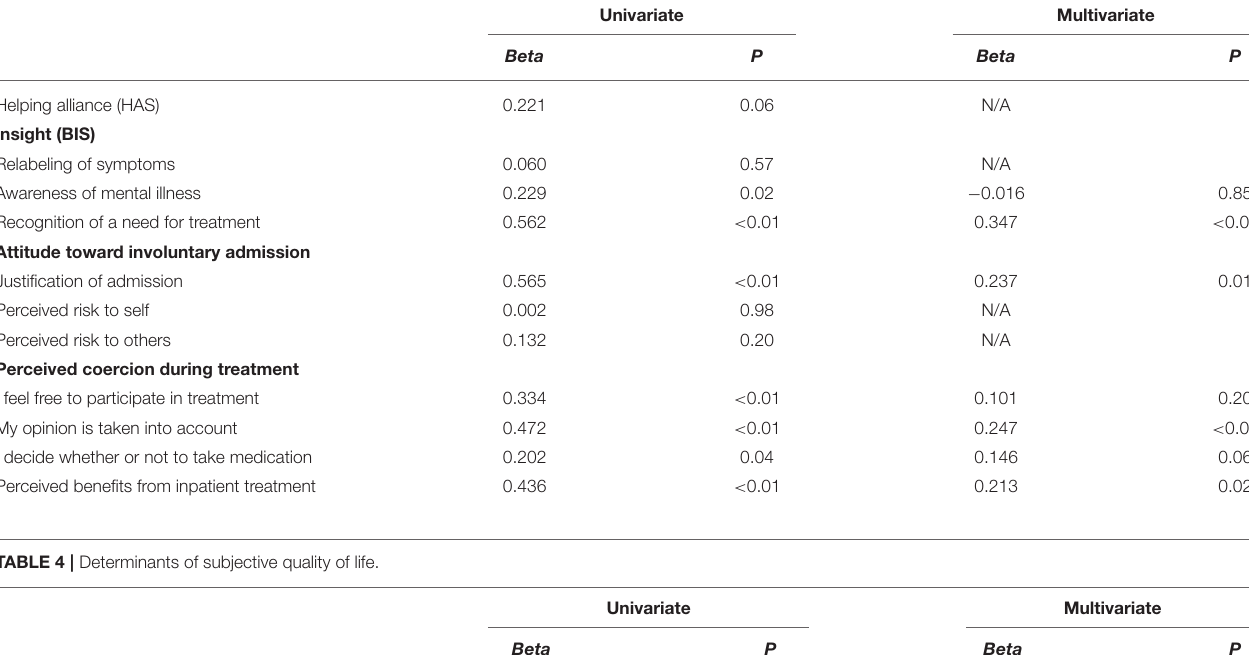
TABLE 3 | Determinants of treatment satisfaction.